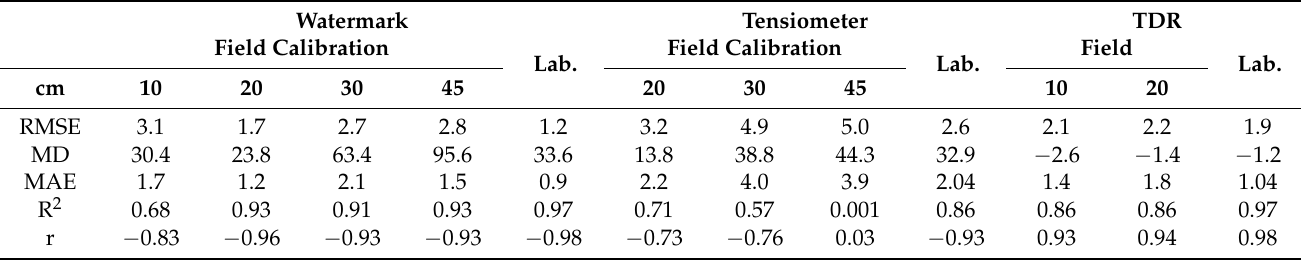
Table 2. Field vs. laboratory